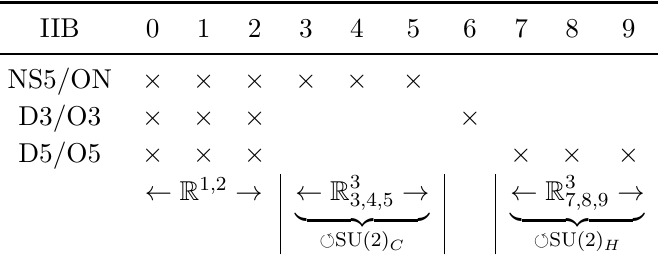
Table 2. Space-time occupation of the D3-D5-NS5 setup of [29]. Likewise, O3 or O5 planes occupy the same directions as D3 or D5 branes, respectively; while ON planes are parallel to NS5